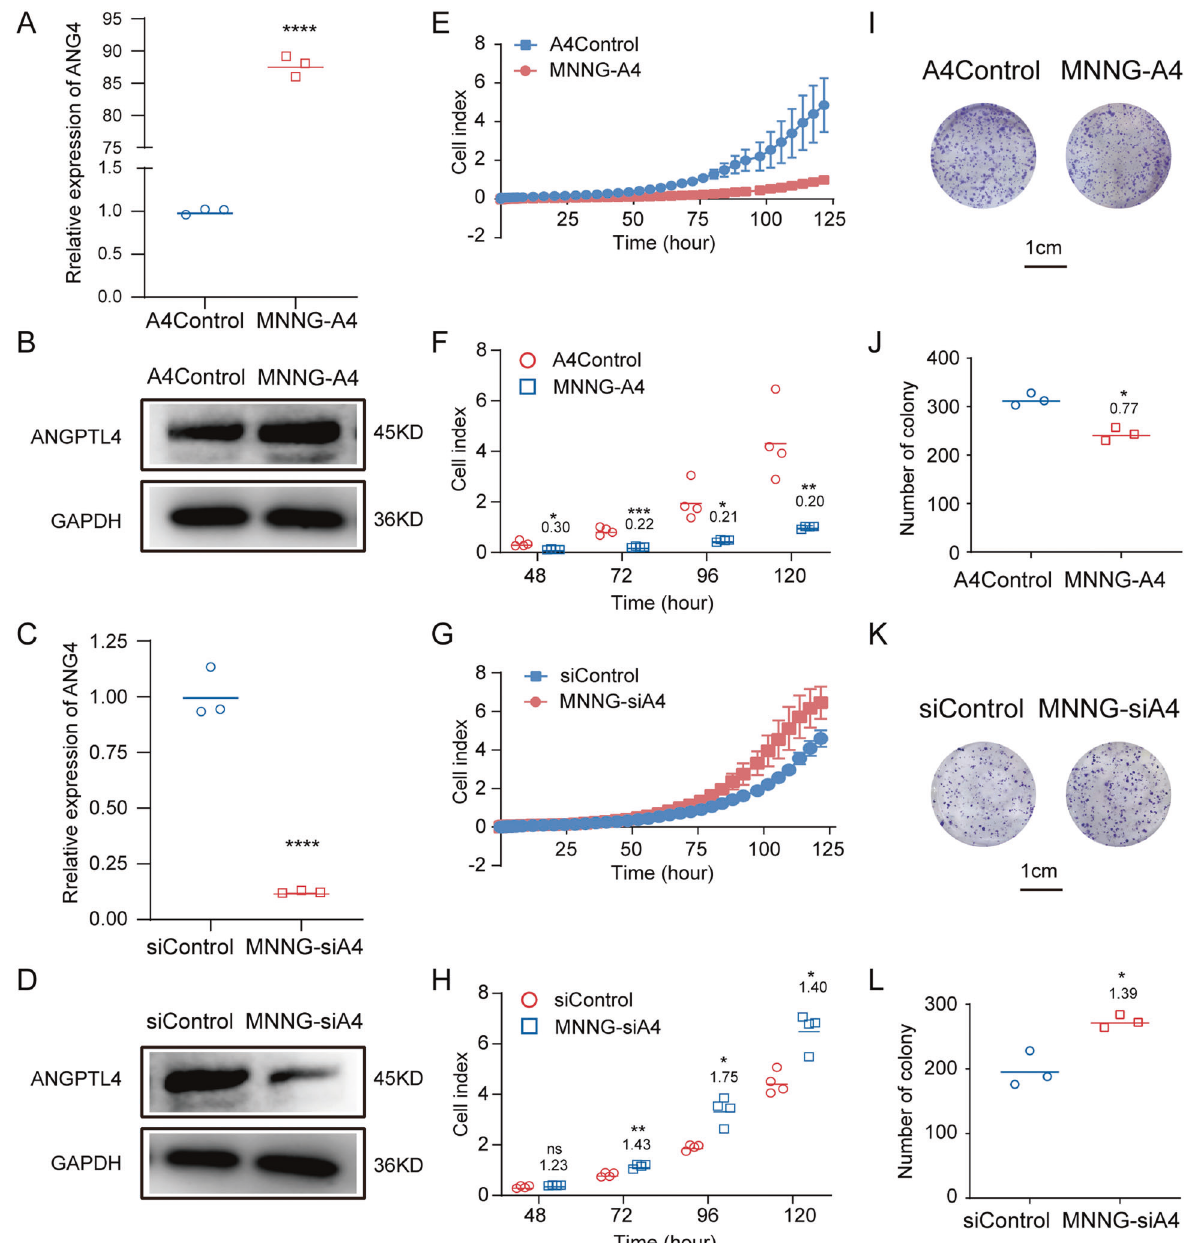
Fig. 2 Knockdown of ANGPTL4 promotes the growth of MNNG cells in vitro. A – D Quantitation of ANGPTL4 mRNA and ANGPTL4 protein expression in MNNG-A4, MNNG-siA4, and control cell lines by RT-qPCR and western blot, respectively ( N = 3, **** p < 0.0001 vs. the control group). E , G In vitro measurement of cell proliferation in two ANGPTL4-regulated MNNG cell lines (MNNG-A4, MNNG-siA4) and control cell lines. The cell index results indicate that cell proliferation is enhanced in the MNNG-siA4 cells but reduced in the MNNG-A4 cells compared to the control cells ( N = 4). F , H Cell index at 48, 72, 96, and 120 h ( N = 4, ns p > 0.05, * p < 0.05, ** p < 0.01, *** p < 0.001 vs. the control group). I , K Representative images of colony formation assays of the MNNG-A4, MNNG-siA4, and control cells. J , L Quantitation of colony counts after 2 weeks of in vitro maintenance ( N = 3, * p < 0.05 vs. the control